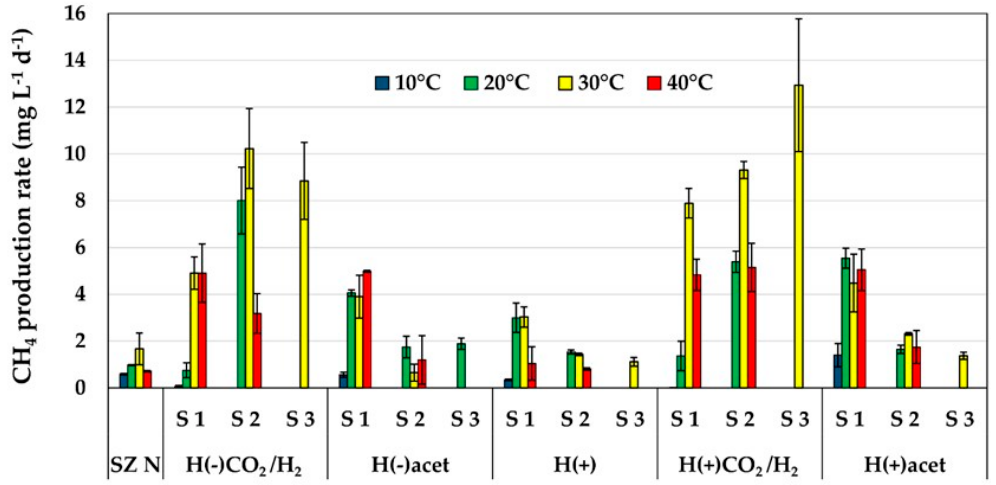
Figure 1. Methane production rate in particular media and stages of enrichment. Mean values with standard deviation (SD) are presented.